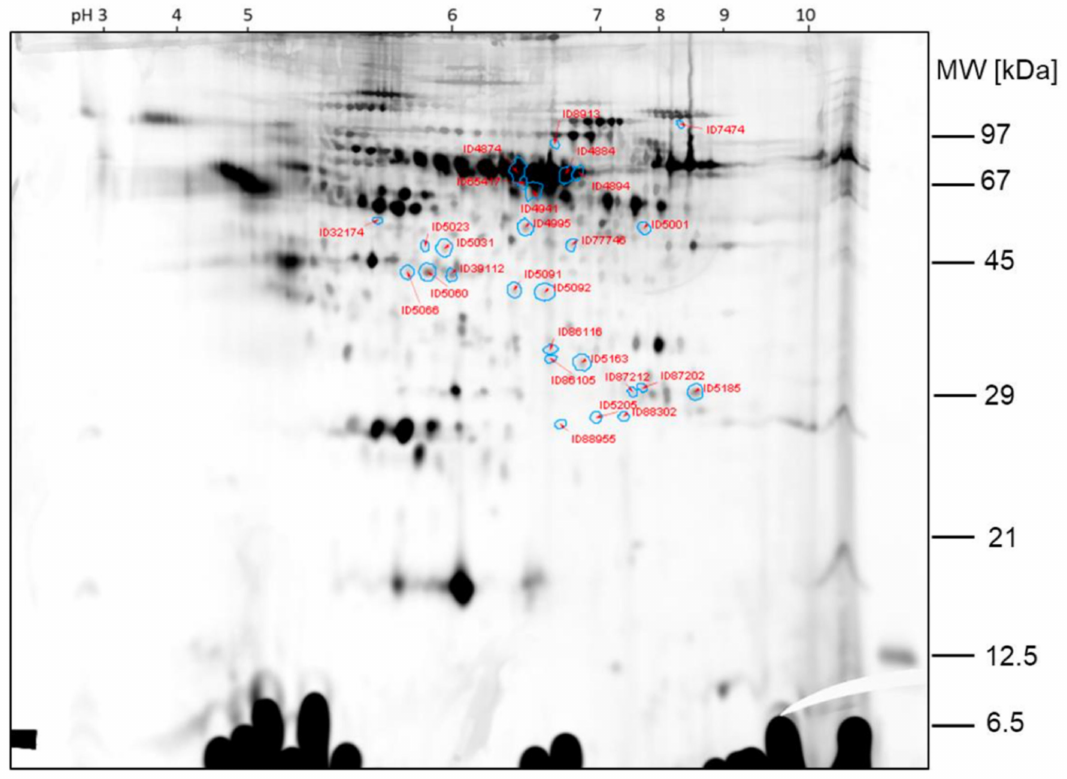
Figure 6. Comparison 2: Spots found >2-fold higher expressed in sample